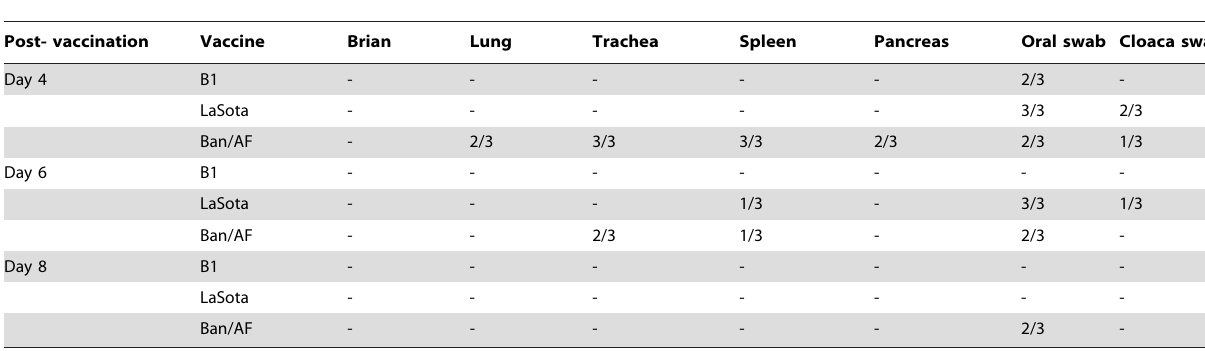
Table 6. Vaccine virus replication and shedding in 2-week-old chickens.